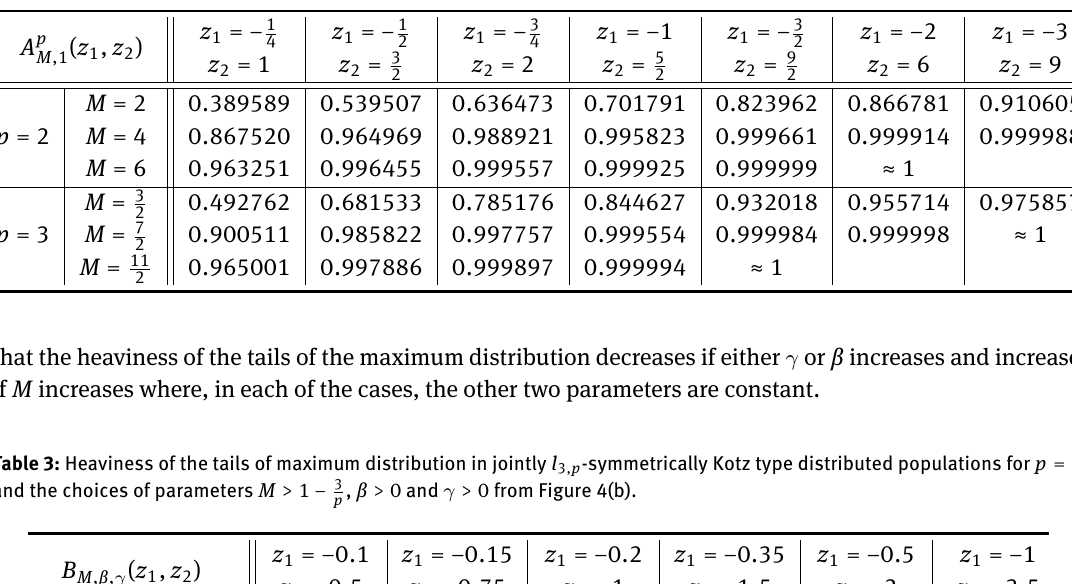
Table 2: Heaviness of the tails of maximum distribution in jointly l 3, p -symmetrically Pearson Type VII distributed populations with ( p , M ) ∈ (cid:8) (2, 2) , (2, 4) , (2, 6) , (cid:0) 3, 3 2 (cid:1) , (cid:0) 3, 7 2 (cid:1) , (cid:0) 3, 11 2 (cid:1)(cid:9) and ν = 1 .